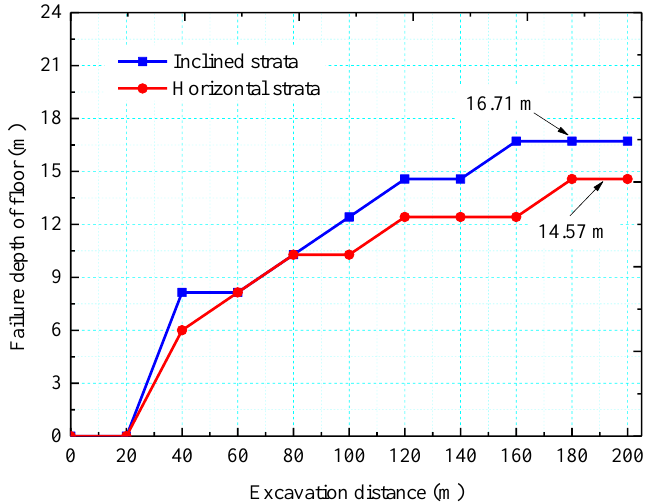
Figure 10. Failure depth of the floor with varying excavation distance.